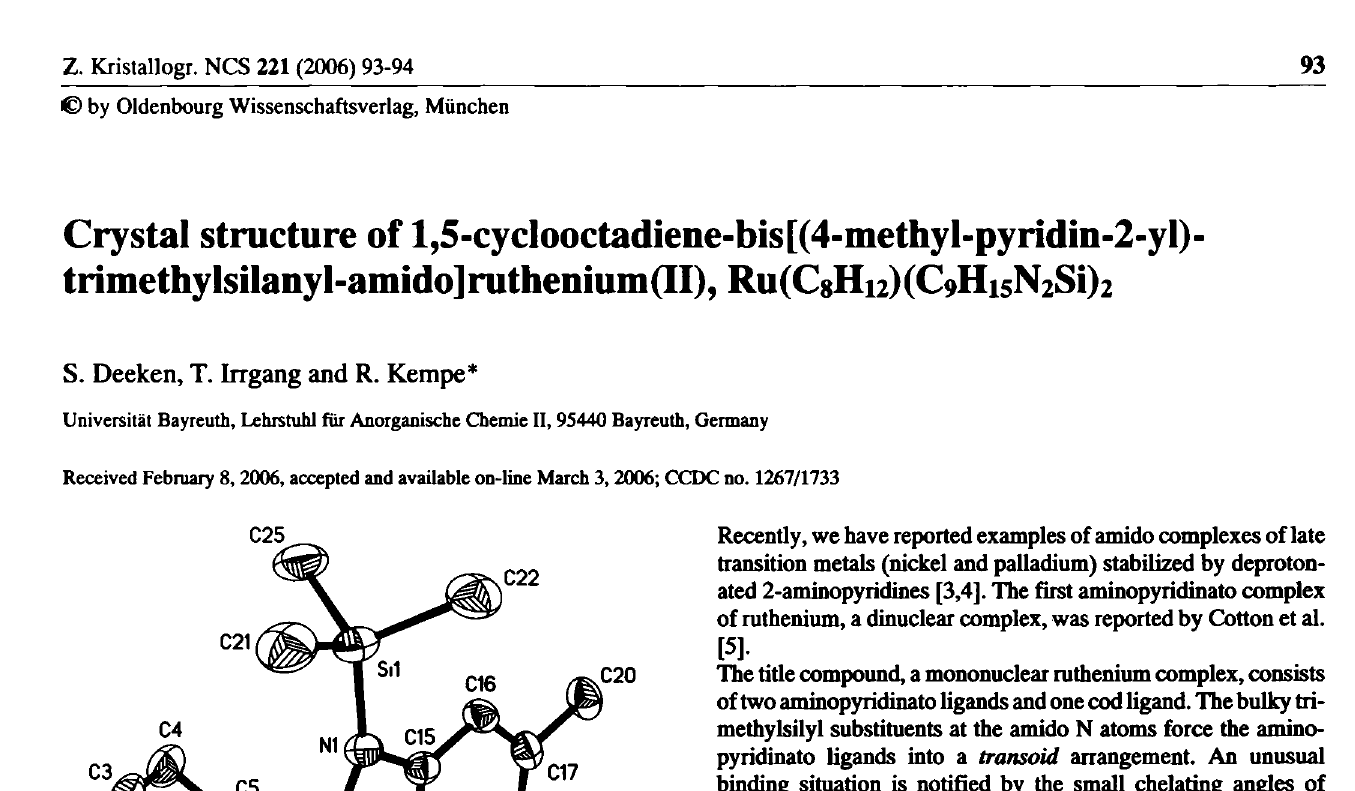
Table 1. Data collection and handling.